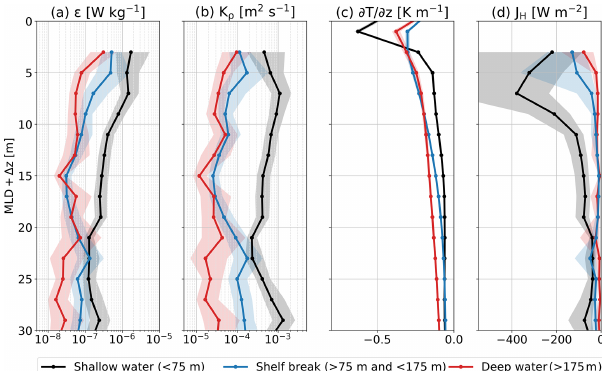
Figure 8. Averaged profiles as a function of distance to the ML. Pro- files taken during six different cruises are allocated into three groups according to the water depth at which the profile was taken. Profiles taken in shallow water (water depth < 75m, black), in the area of the shelf break (water depth > 75 and < 175m, blue), and in deep waters (water depth > 175m, red) are grouped together. (a) The dis- sipation rate of TKE [Wkg − 1 ], (b) the eddy diffusivity [m 2 s − 1 ], (c) the vertical temperature gradient [Km − 1 ], and (d) the turbulent heat flux [Wm − 2 ]. The shaded areas give the 95% confidence in-